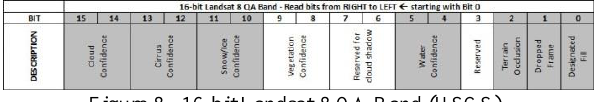
Figure 8. 16-bit Landsat-8 QA Band (USGS)